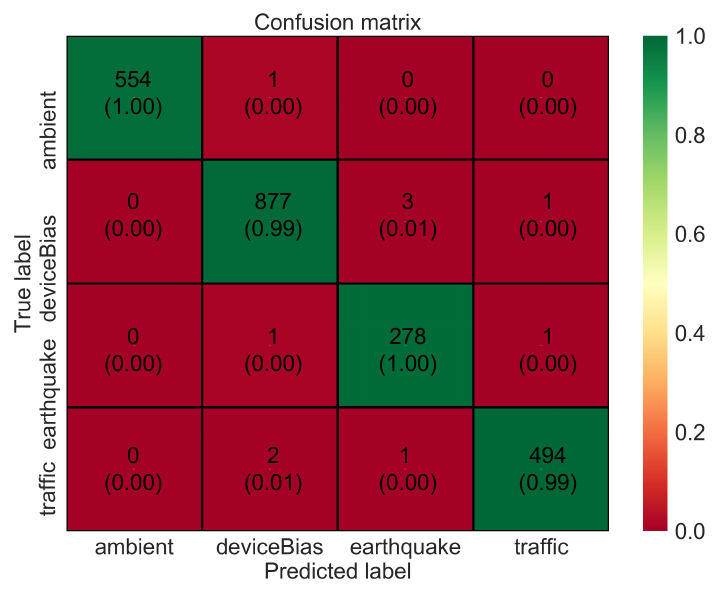
Figure 13. Confusion matrix for Alex Net model with augmented dataset.